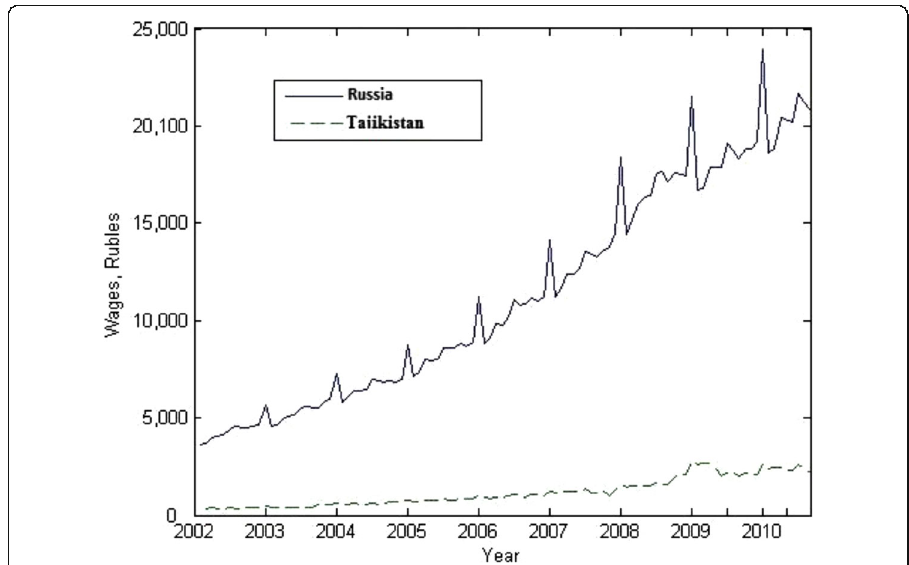
Fig. 1 Comparison of real wages between Russia and Tajikistan, Rubles. Data sources: (1) Data on wages and consumer price index in Tajikistan are from the website of the State Statistical Agency of Tajikistan (State Statistical Agency of Tajikistan 2011). (2) Data on wages and consumer price index in Russia are from Russian State Statistical Committee Monthly Reports on Social and Economic Conditions of Russian Federation (Russian State Statistical Committee 2010). (3) Exchange rates used in converting Tajikistan ’ s wages to Russian Rubbles are from the website of the National Bank of Tajikistan (National Bank of Tajikistan